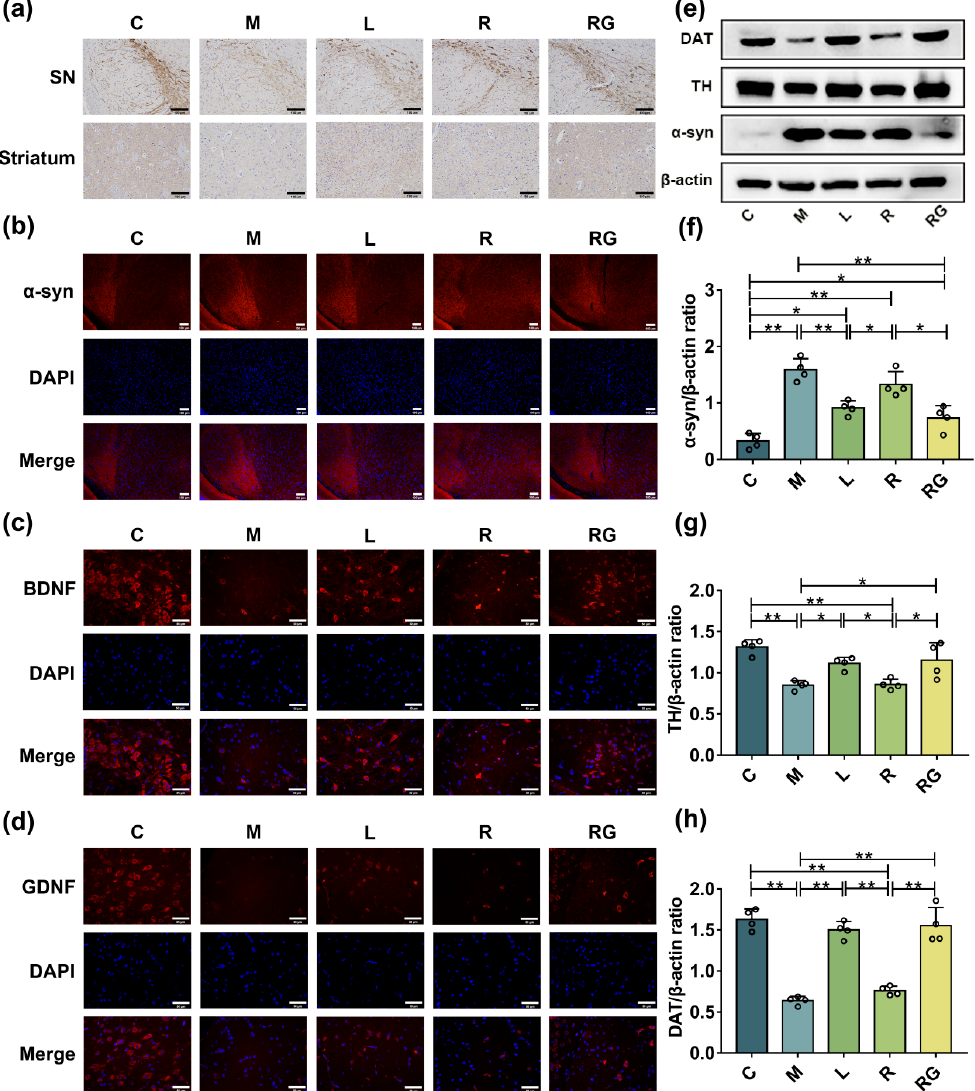
Figure 2. L. lactis MG1363-pMG36e-GLP-1 suppressed DAergic neurons death and synucleinopa- thy in PD model mice. ( a ) Photomicrographs of TH + neurons in the SN and ST by IHC staining (scale bar = 100 µ m). ( b ) Photomicrographs of α -syn in SN by IF staining (scale bar = 100 µ m). ( c , d ) Photomicrographs of BDNF and GDNF in the SN of PD mice by IF staining (scale bar = 50 µ m). ( e ) Western blotting of α -syn, TH, DAT, and β -actin in SN. ( f – h ) Relative quantification of α -syn, TH, and DAT protein levels adjusted to internal reference β -actin ( n = 4). * p < 0.05 and ** p <